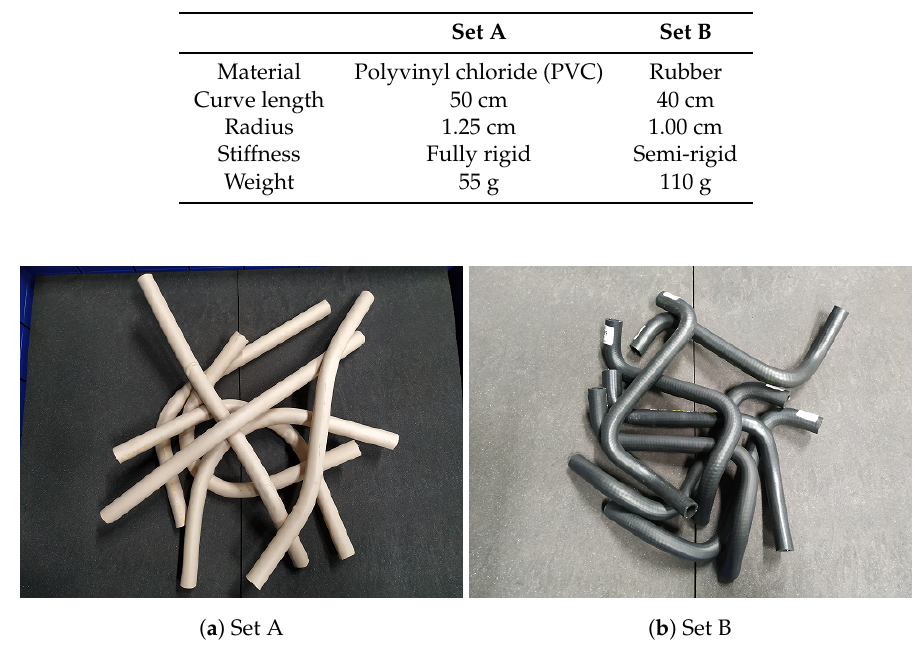
Table 1. Main properties of the considered sets of tubes.